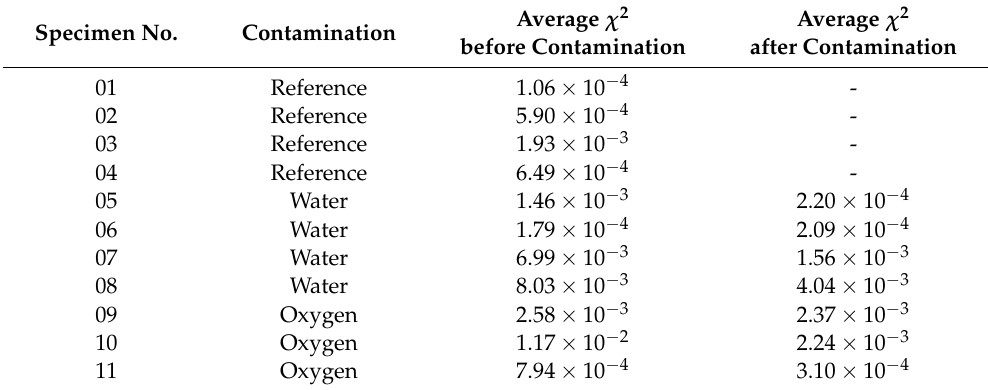
Table 3. Average goodness of fit expressed in terms of χ 2 for the fitted EIS measurements with the equivalent circuit with the ECM parameters R 0 , R 1 , R 2 , CPE 1 and CPE 2 . Specimen